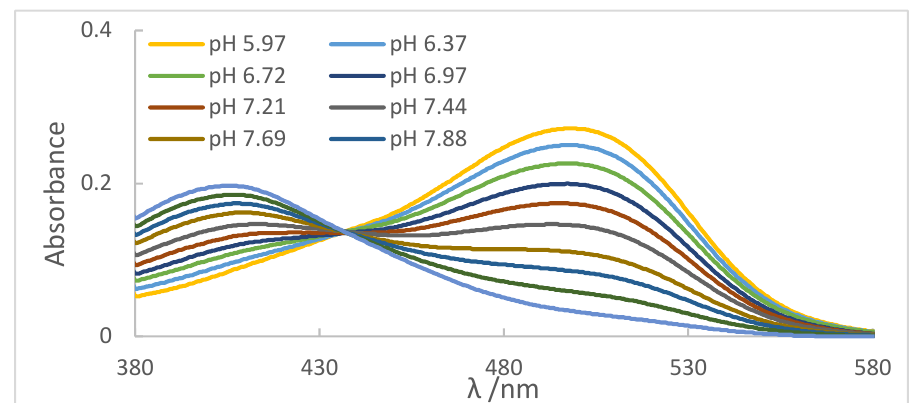
Figure 4. Spectra obtained for each of the aliquots using the methyl red indicator.